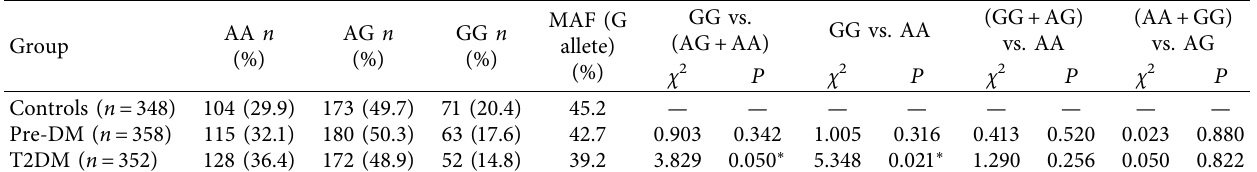
Table 2: Genotypes and allele frequencies for the SLC2A9 A/G (rs1014290) SNP in the control, prediabetic, and type 2 diabetic groups. AA n AG n Group (%)